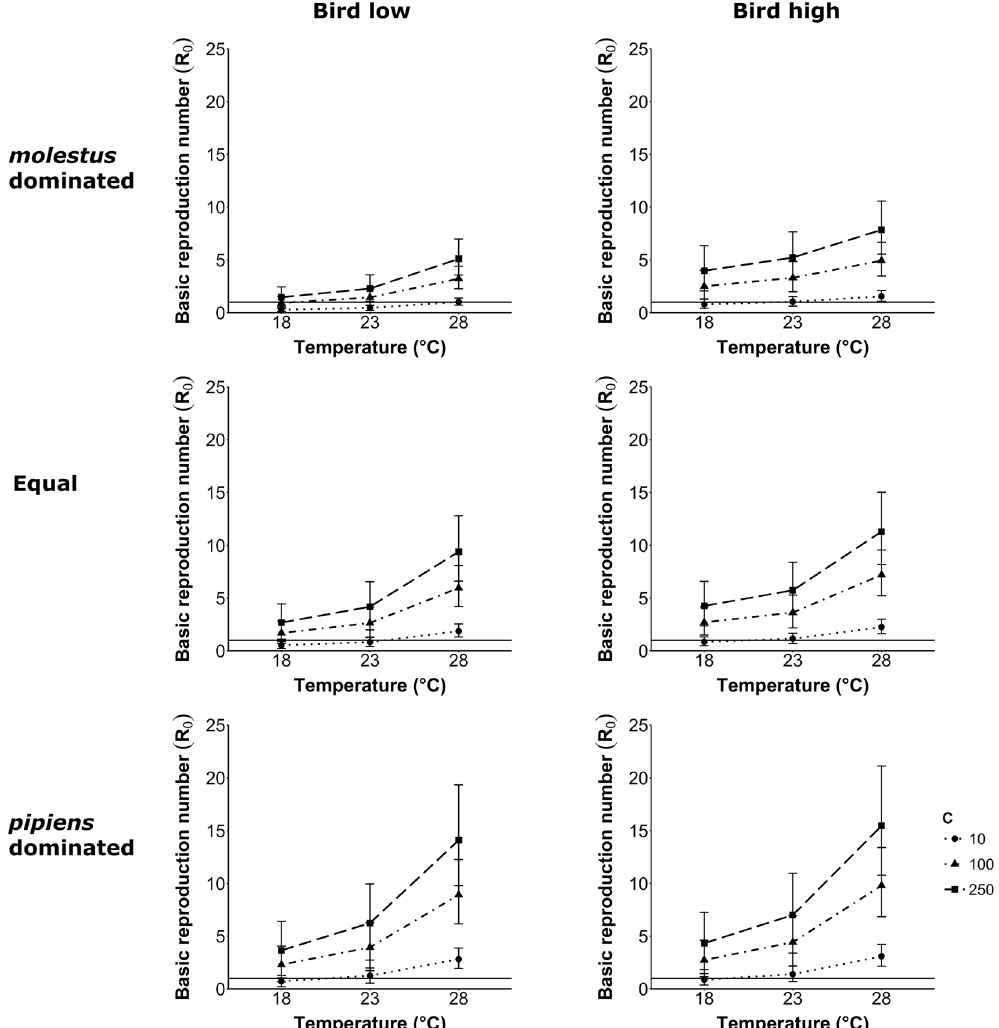
respectively) and one of the three different mosquito population compositions ( molestus dominated, equal fractions, or pipiens dominated). Each plot shows the mean R 0 out of 100,000 model calculations, with error bars showing the 95% range of calculated R 0 values for three temperature scenarios (T = 18 °C, 23 °C, and 28 °C) and three different mosquito-to-host ratios ( C = 10, 100, or 250). The horizontal line indicates an R 0 value of one. Values of R 0 above one indicate that there is a chance of West Nile virus